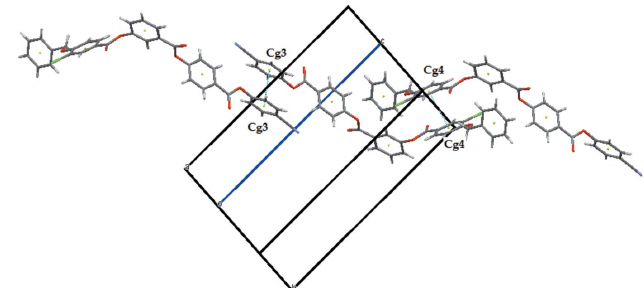
Figure 3 The molecular packing of the title compound. Dashed lines indicate the (cid:2) – (cid:2) stacking interactions.